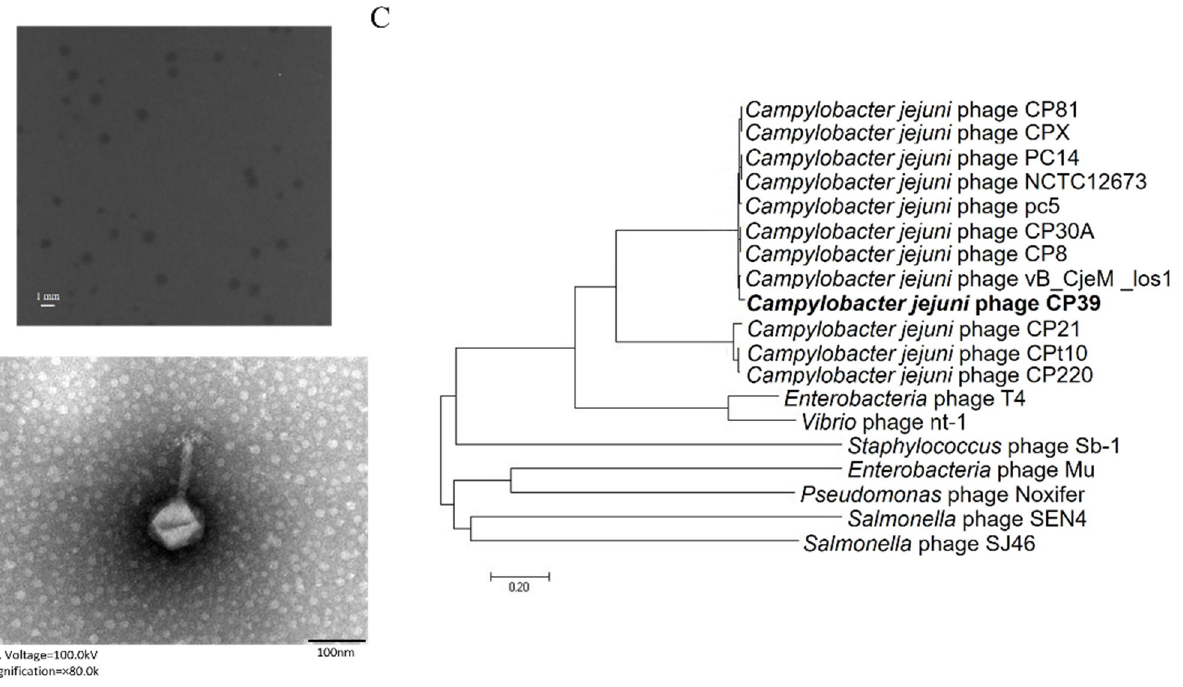
Figure 1. Identification and characterization of Campylobacter jejuni phage CP39. ( A ) The plaque morphology of C. jejuni phage CP39. ( B ) transmission electron microscopy (TEM) image of phage CP39 indicating the phage belongs to Myoviridae family. ( C ) The phylogenetic relationship of phage CP39. Additional information of genomes was listed in Table S2.